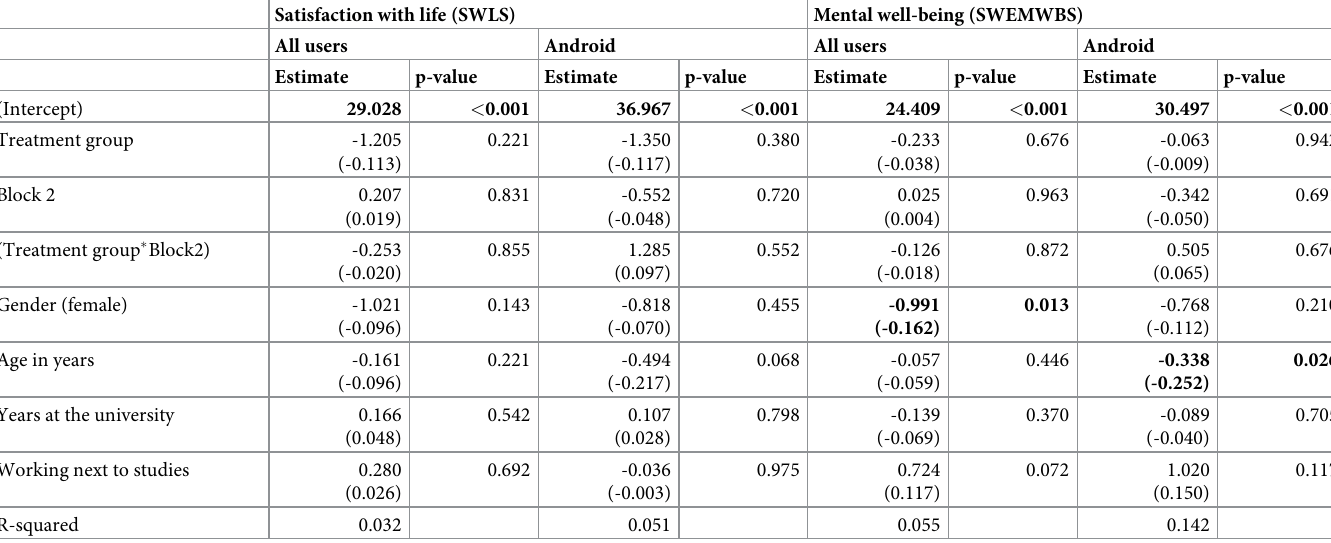
Table 6. Regression of satisfaction with life and mental well-being measures (standardized coefficients in parentheses).